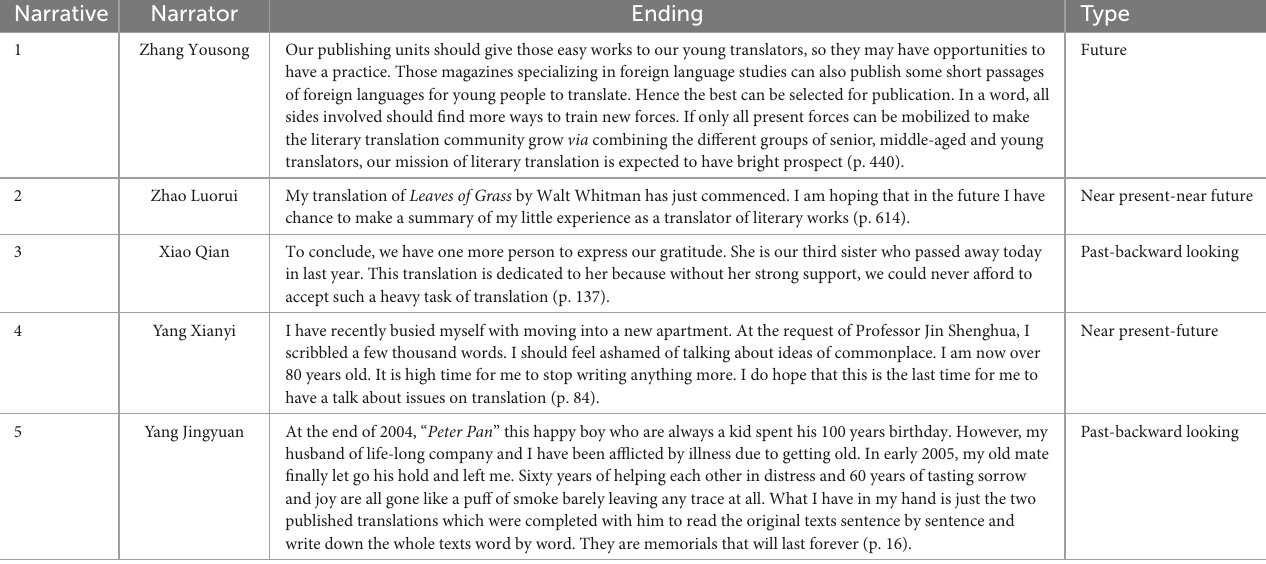
TABLE 5 Different endings of narratives.